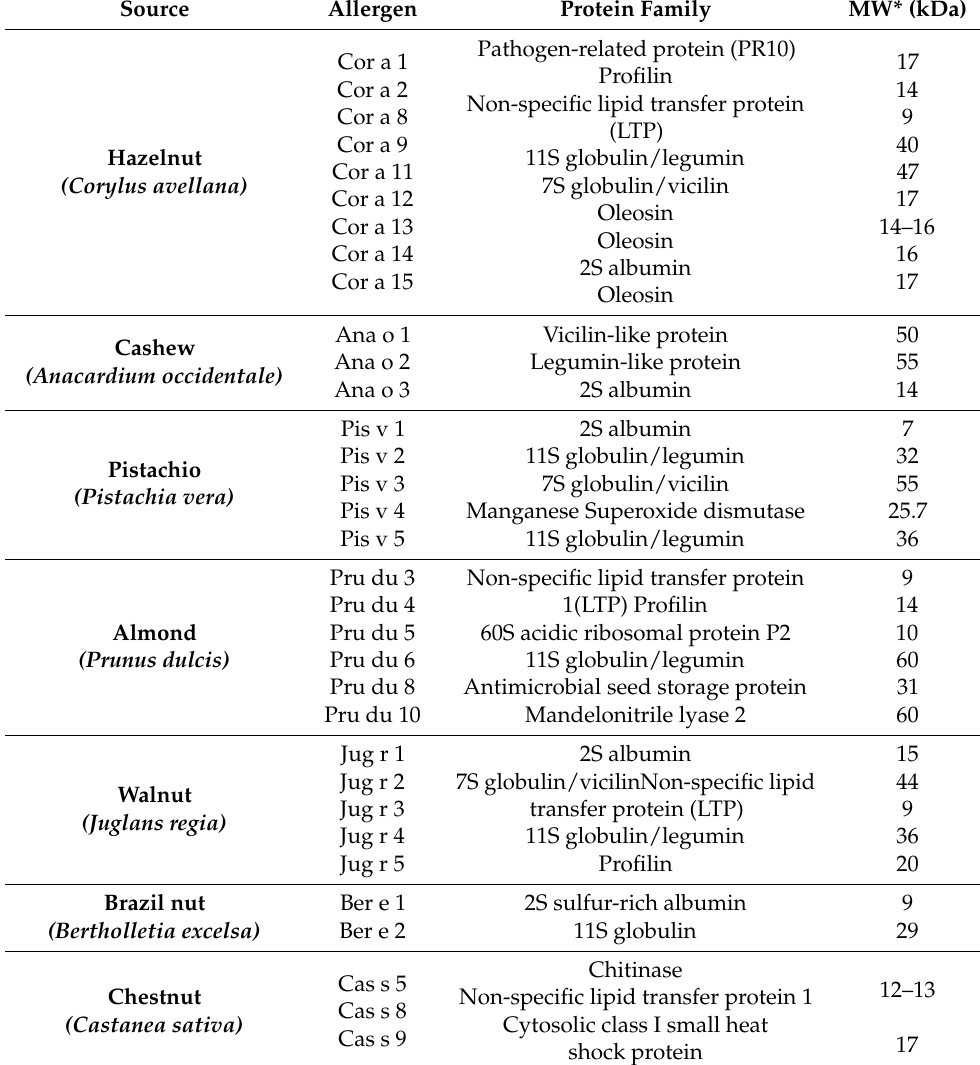
Table 1. Allergens in nuts (WHO/IUIS Allergen Nomenclature